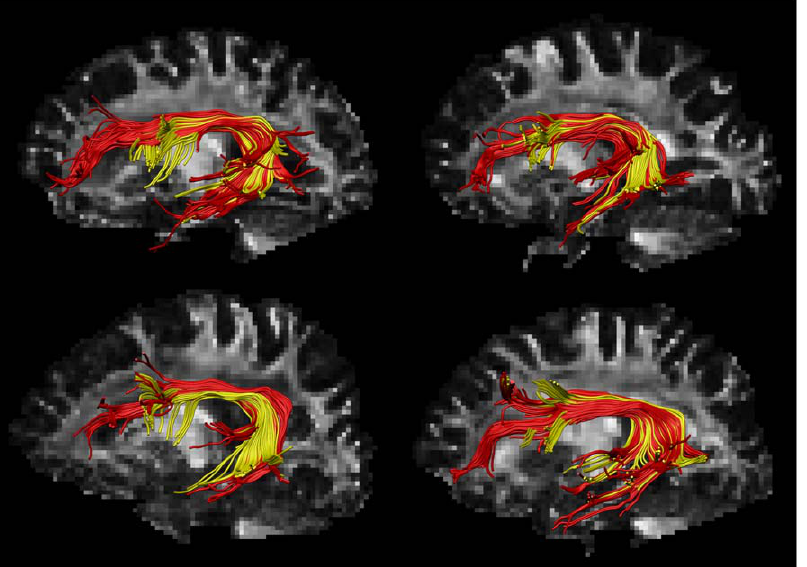
Figure 6. Segmentation of the superior longitudinal fasciculus (SLF) with DTI and CSD based fiber tractography. Segmentation of the SLF in four patients reconstructed with DTI (yellow) and CSD (red) based fiber tractography (FT). Delineation of the SLF resulted in larger and longer pathways with CSD compared to DTI based FT. With the DTI method, fibers of the SLF were more likely to terminate at crossings between the SLF and the cortico-spinal tract in frontal regions and between the SLF and the inferior longitudinal fasciculus in temporal regions.